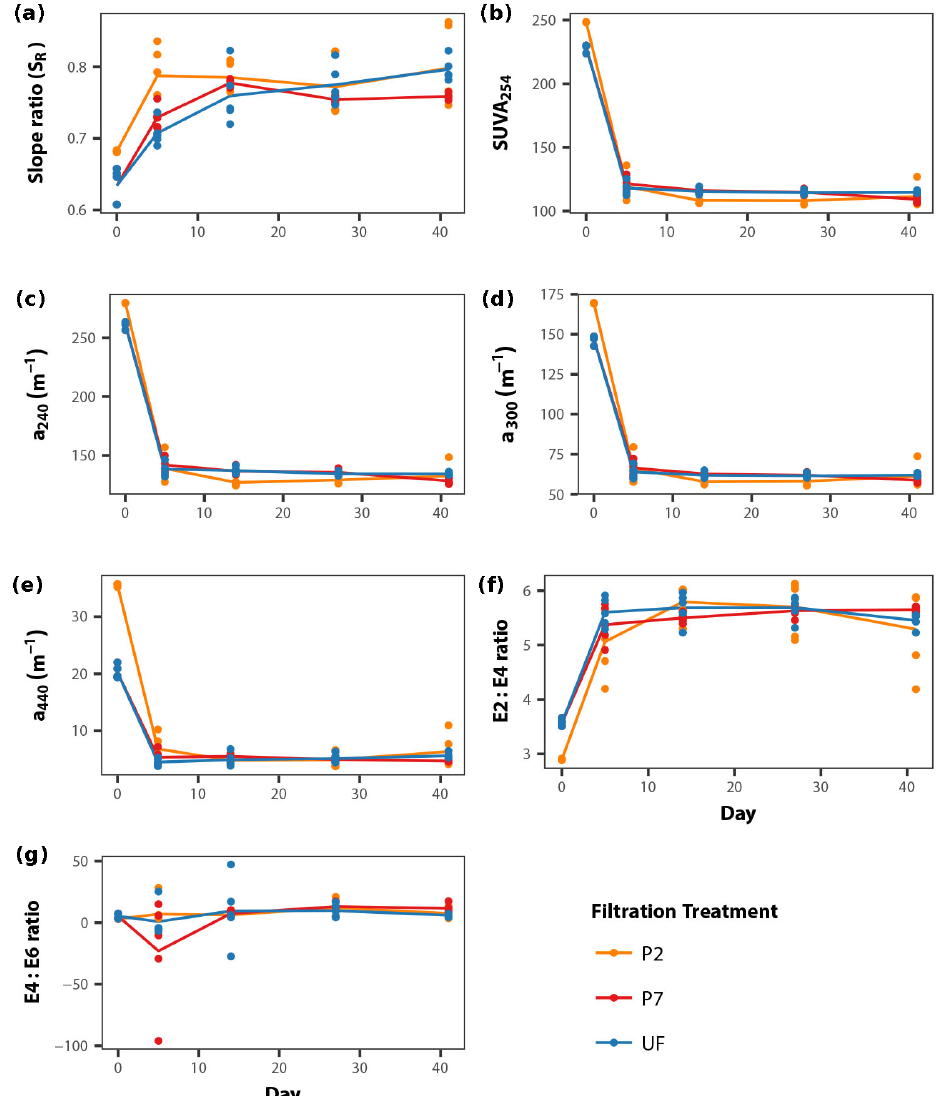
Figure 3. DOM quality (structural proxies) dynamics during the course of the incubations for each filtration treatment, separated into the seven different DOM structural indices used in this study ( a – g ; see Sect. 2.3). Points represent individual replicates; lines connect mean values calculated for each day × treatment combination (Table